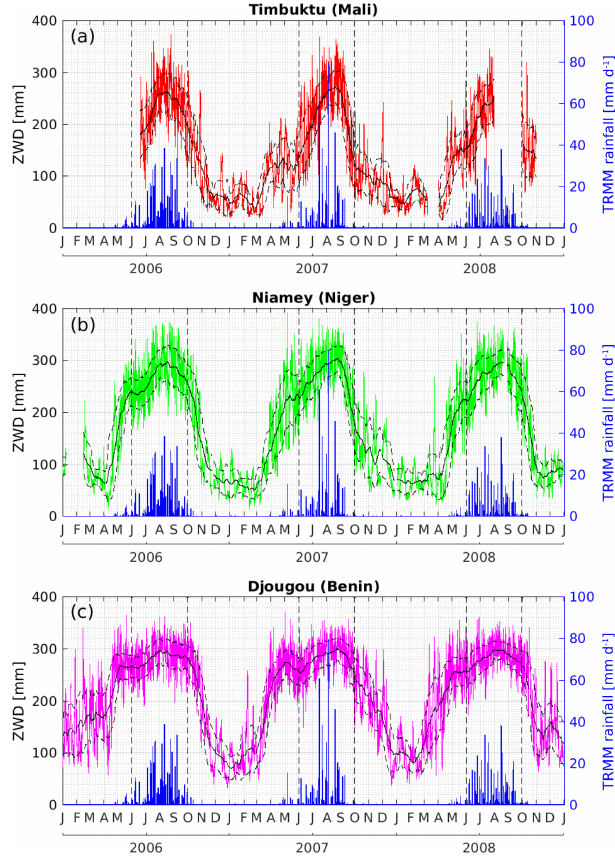
Figure 2. Time series of GPS-derived ZWD values retrieved with the GAMIT software and rainfall retrieved from the TRMM Multi- satellite Precipitation Analysis (Huffman et al., 2007) at (a) Tim- buktu, (b) Niamey, and (c) Djougou. The thin black solid and dashed lines show 30d moving averages and standard deviations, respectively. The dashed black vertical lines delimit the period be- tween June and September corresponding to the main rainy season.